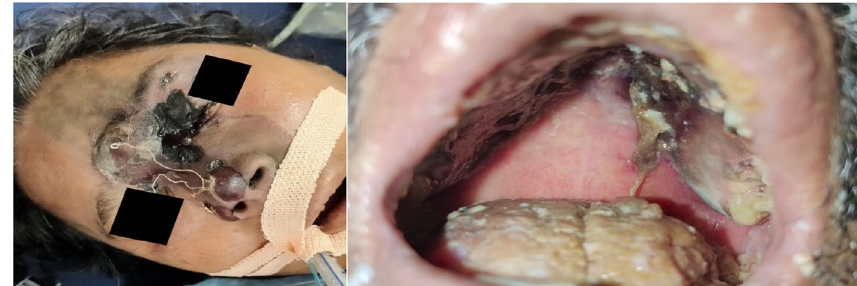
Fig. 1 Showing A CAM patient with black eschar around the orbit, another patient with palatal necrosis with black crusts